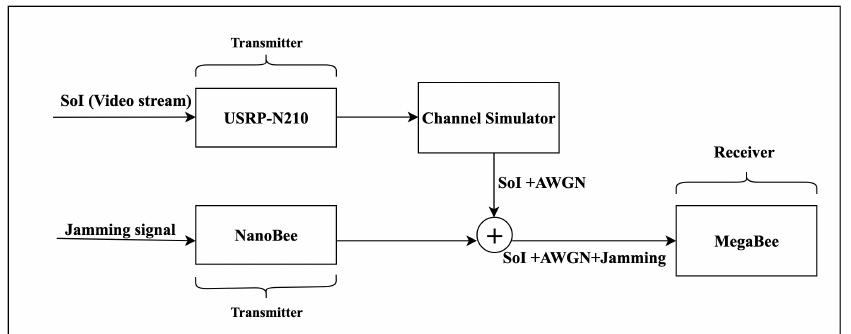
Figure 2. Real-time RFI data acquisition set-up.